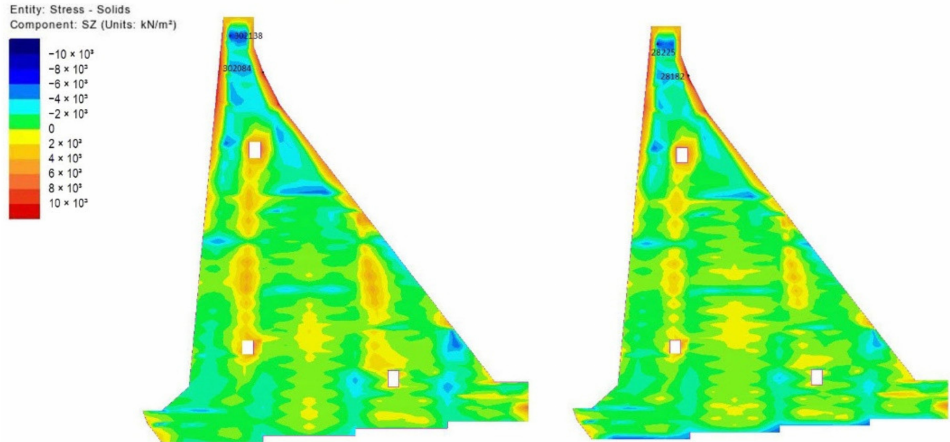
Figure 21. Stresses σ z in the mid-plane of the monolith 20 m long ( left ) and 15 m long ( right ) for the 512th day (13th of March of the third year); extremums: nodes 302,084 and